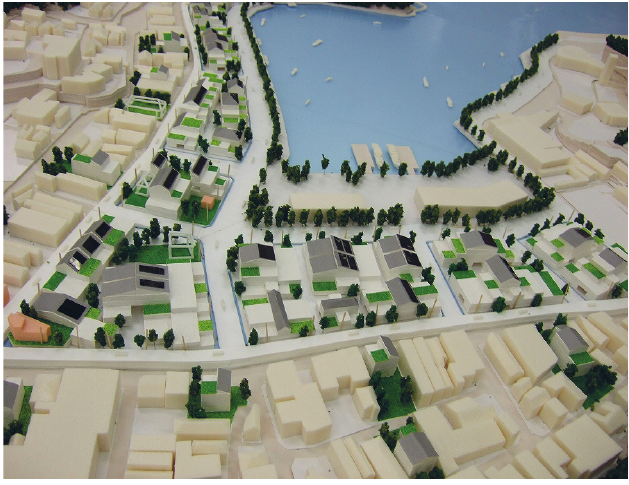
Figure 21. Bird’s-eye view of reconstructed Kesennuma Bay area (Image as represented by architectural